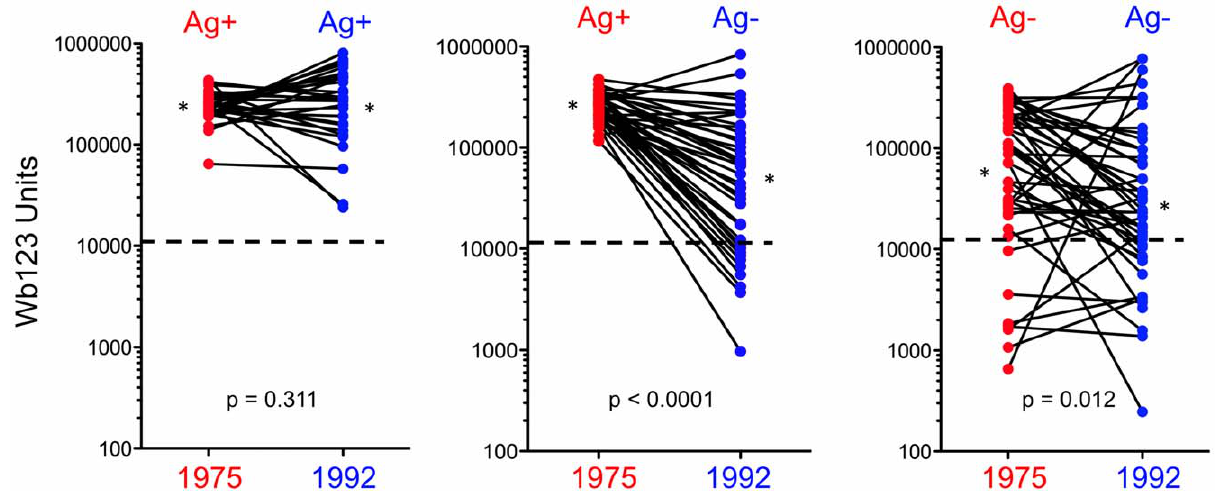
Figure 4. Levels of Ab to Wb123 in Patients Seen in Both 1975 and 1992. Change in the production of Ab to Wb123 as measured by LIPS in individuals seen in both 1975 (red dots) and 1992 (blue dots) segregated by CAg status. Each line represents an individual patient (n=28 [CAg + to CAg + ]; n=40 [CAg + to CAg 2 ]; n=46 [CAg 2 to CAg 2 ]); asterisks represent the geometric means for each group. The dashed line in each graph represents the upper limit of the normal level (10,968 units) of the LIPS assay and p-values were calculated using the Wilcoxon Signed Rank test.